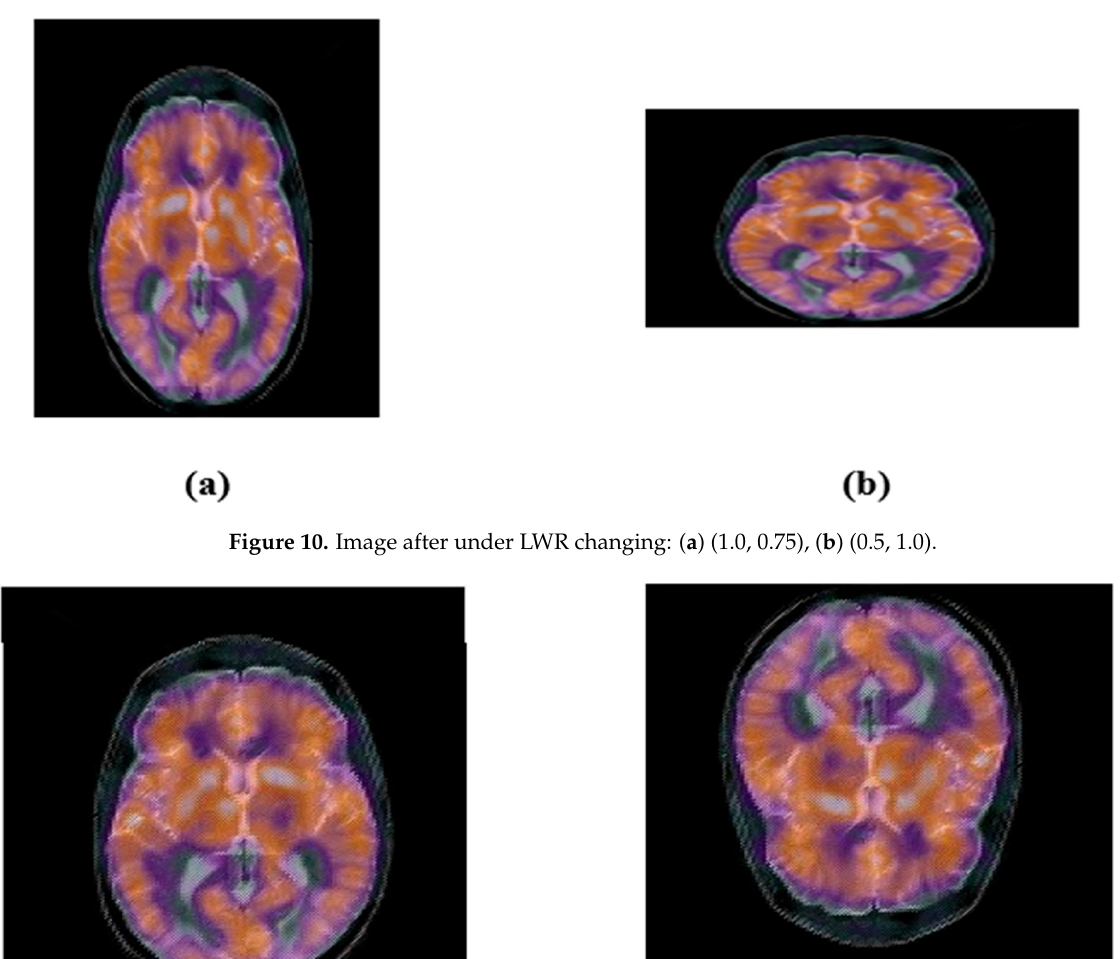
Figure 9. Scaled images: ( a ) 0.5, ( b ) 0.75, ( c ) 1. 5, ( d ) 2.0.